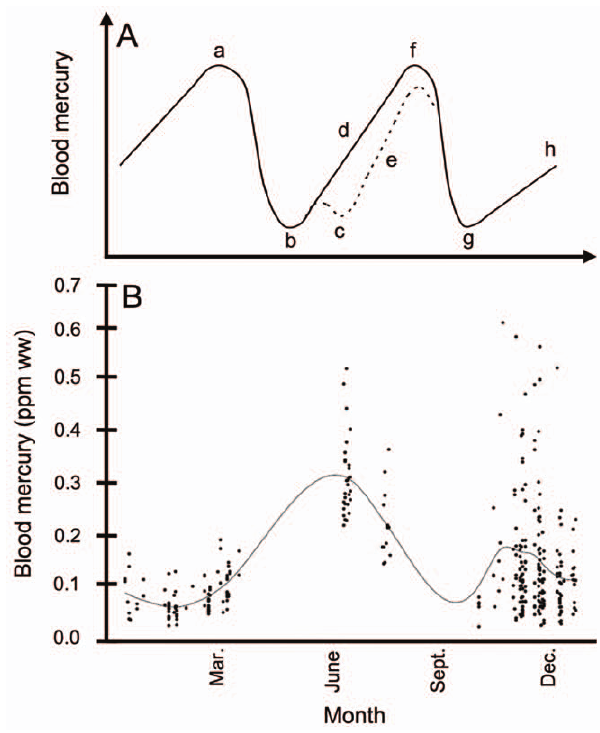
Figure 2. Blood mercury dynamics in a biannually molting migratory songbird. (A) Hypothetical model of changes in blood mercury with respect to physiologically dynamic events in the annual cycle of a biannually molting, migratory songbird. This simplified model assumes a constant mercury exposure year-round and is intended only to represent potential relative changes in blood mercury due to physiologically dynamic events in an individual’s annual cycle. Between prebasic and prealternate molts, mercury increases during the non- breeding season (a, h); at spring prealternate molt, mercury decreases (b); females deposit mercury into eggs (c); mercury increases between prealternate and prebasic molts during the summer [d (males), e (females)], reaching a maximum before fall prebasic molt (f); following prebasic fall molt, mercury is depleted (g). (B) Blood mercury data with a smoothed best-fit line for breeding and non-breeding Nelson’s Sparrow populations at JBON and WBNC, respectively (refer to Fig. 1 for capture location